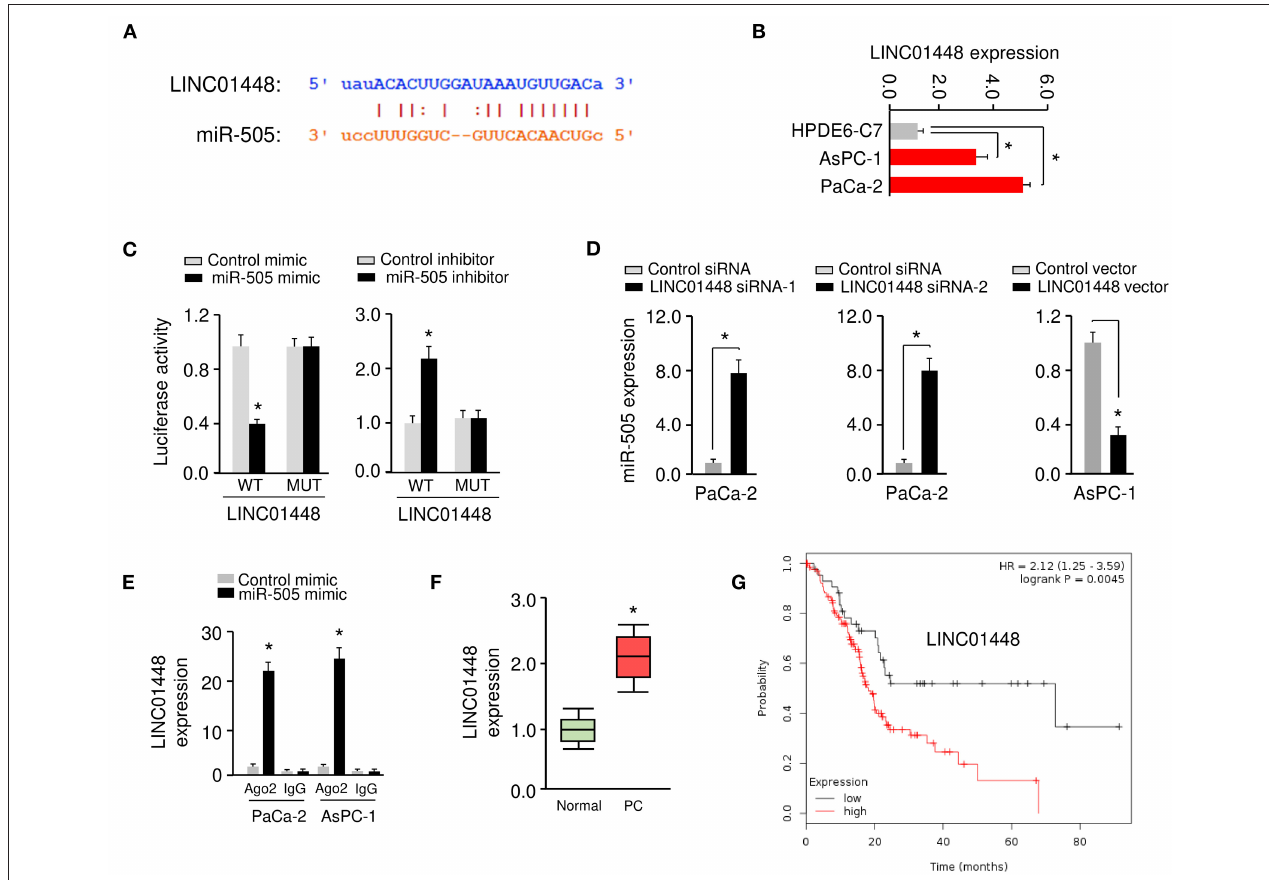
FIGURE 6 | LncRNA LINC01448 directly binds to miR-505 and represses its expression. (A) Putative binding sites between miR-505 and LINC01448. (B) qRT-PCR analysis of LINC01448 expression in PC cell lines and normal pancreatic cells using. (C) Luciferase activity in PaCa-2 cells transfected with WT or MUT LINC01448, along with (or without) miR-505 mimic, or in AsPC-1 cells transfected with WT or MUT LINC01448, along with (or without) miR-505 inhibitor. (D) miR-505 expression in PC cells after LINC01448 knockdown or overexpression of LINC01448. (E) RIP assays were conducted in PC cells transfected with control mimic and miR-505 mimic. LINC01448 expression was analyzed using qRT-PCR analysis. (F) qRT-PCR analysis of LINC01448 expression in PC tissues and normal tissues. (G) Kaplan-Meier curves for the overall survival of PC patients with high or low LINC01448 expression (KM Plotter database). * P <